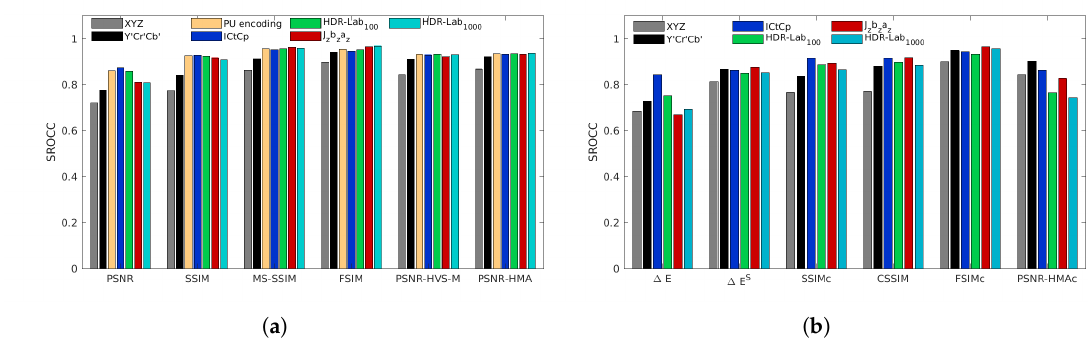
Figure 11. SROCC performances for the Korshunov et al. database for color-blind quality metrics ( a ) and for color quality metrics ( b